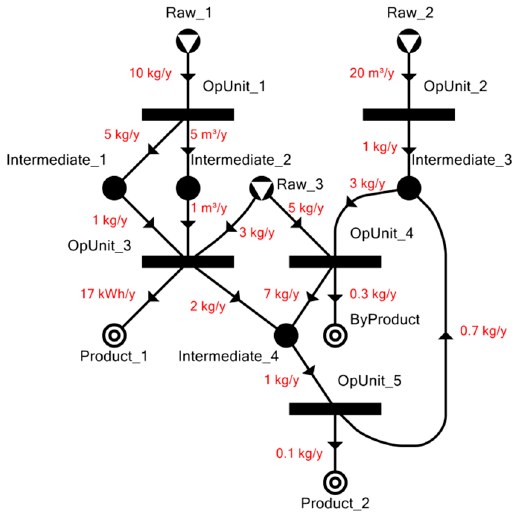
Figure 1. Example P-Graph with five operating units, three possible raw materials, two desired final products, and a byproduct. Note that cycles are possible in P-Graphs.